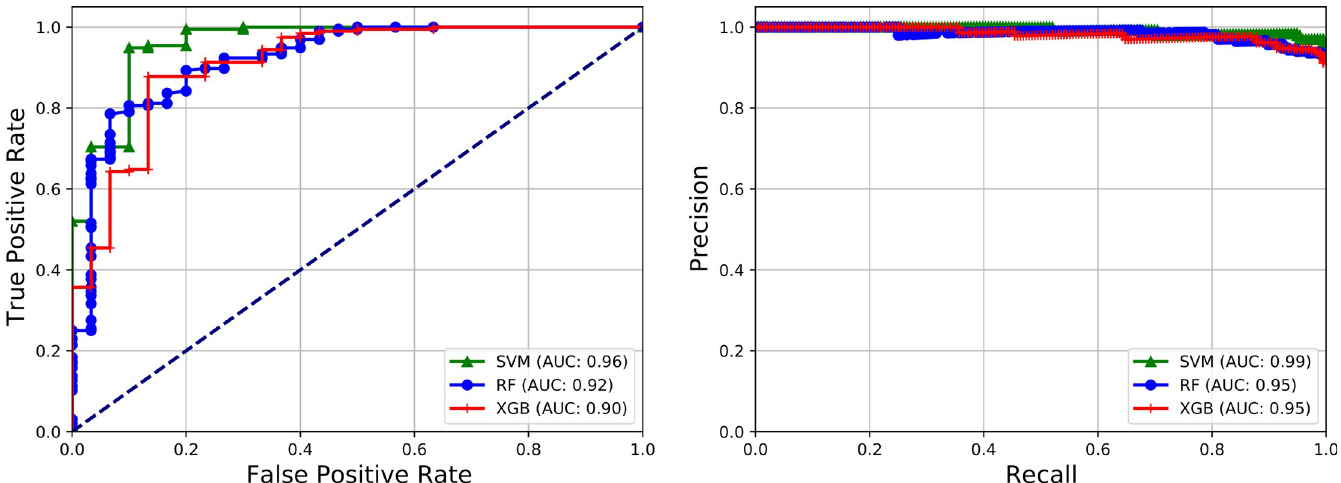
Fig 2. Receiver Operating Characteristic (ROC) and Precision-Recall (PR) curves showing predictive performance of our proposed model for the classification of digital images of earthworms across different classifiers (SVM, RF, XGB) and DenseNet feature map on an external validation dataset. E. fetida vs others: ROC(A), PR(B).